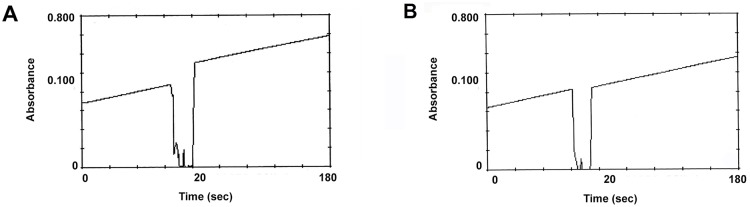
Competitive pattern of brain AChE inhibition by methyl-paraoxon (MP).The graphs show the progress of the AChE assays by Ellman’s method for mullet (Mugil liza) (A) and hen (Gallus domesticus) (B) enzymes. After 1 minute of enzyme reaction, a final concentration of 50μM (A) and 0.5μM (B) of MP was obtained by adding the same volume of the MP methanol solution, following 3 minutes of enzyme reaction. Initial enzyme activities were prepared the same way for the two enzymes and inhibitor concentrations were prepared to allow for 80% inhibition after 2 minutes of incubation without any substrate for the two enzymes. The valleys represent the moments of MP addition. The higher absorbance after the addition of MP for M. liza enzyme assay (A) was due to the presence of 4-nitrophenol in the MP solution (maximum of 5%).